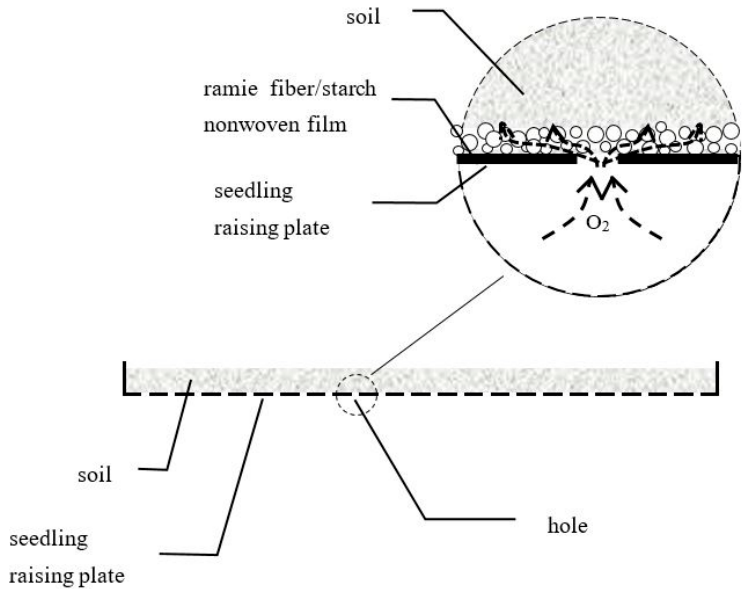
Figure 8. Process of oxygen into soil through diffusion in the ramie fiber/starch nonwoven film.